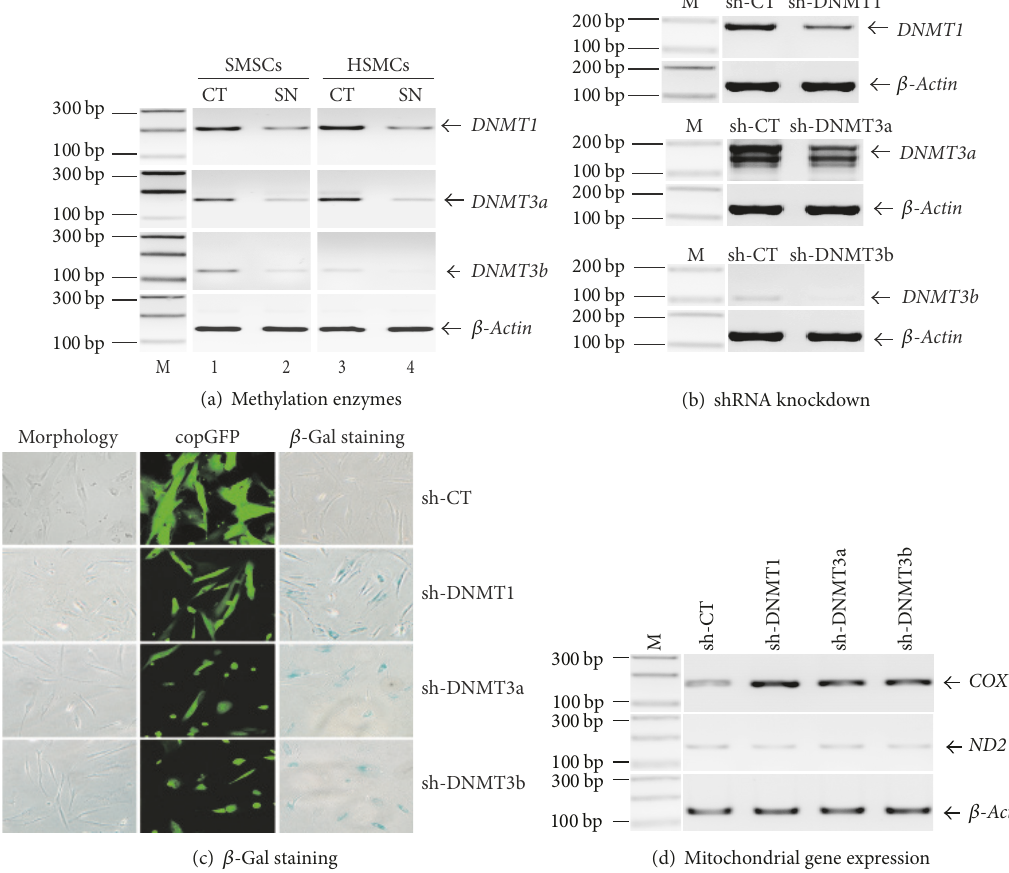
Figure 5: Knockdown of DNMTs induces senescence in MSCs. (a) Downregulation of DNMTs in senescent MSCs. After induction of cellular senescence, cells were harvested and the expression of DNMTs was determined by semiquantitative PCR. (b) Knockdown of DNMTs by shRNAs. Lentiviruses containing DNMT shRNAs (sh-DNMT1, sh-SNMT3a, and sh-DNMT3b) or scramble control (sh-CT) were transduced into HMSCs. After 72 h, transduction efficiency was assessed by the observation of GFP positive cells. Cells were harvested and RNA were extracted, and the expression of DNMTs was determined by RT-PCR. (c) Induction of cellular senescence by DNMT-shRNA knockdown. Left panel: HMSCs morphology taken 7 days after DNMT-shRNA transduction. Sh-CT: shRNA scramble control; sh-DNMTs: HMSCs were transducted by lentiviruses containing DNMT1, DNMT3a, and DNMT3b shRNAs. Middle panel: lentiviral transduction efficiency as shown by copGFP fluorescence of the shRNA vector. Right panel: senescent-associated 𝛽 -Gal staining. After DNMT-shRNA knockdown, MSCs were stained for 𝛽 -Gal activity. Note the occurrence of senescence in DNMT-knockdown MSCs in the absence of peroxide treatment. (d) Expression of COX and ND2 in DNMT-shRNA-treated MSCs. 𝛽 -Actin was used as the internal control for PCR reaction. Cox1 was upregulated in DNMT-knockdown MSCs in parallel with cellular